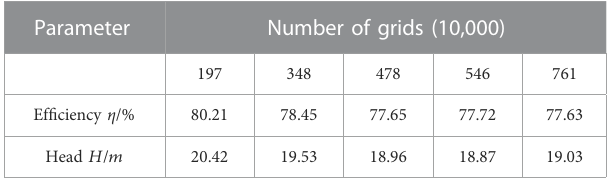
TABLE 2 Grid independence analysis.